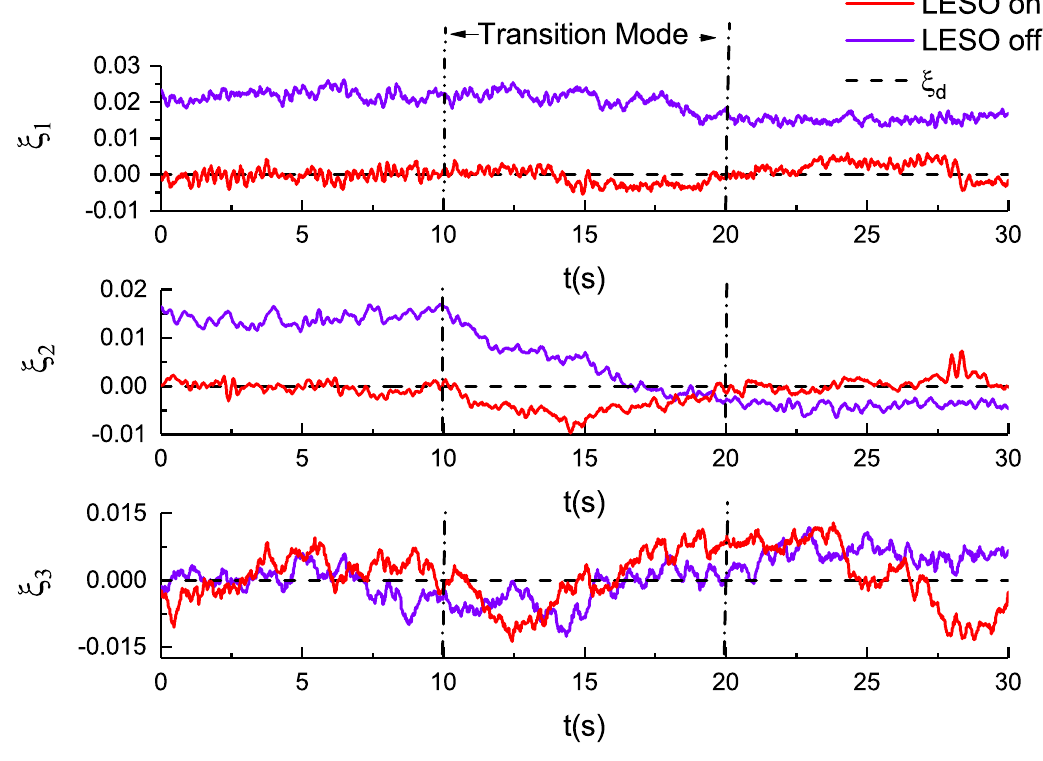
Figure 11. Attitude-stabilization effect with the LESO on and off in transition mode.